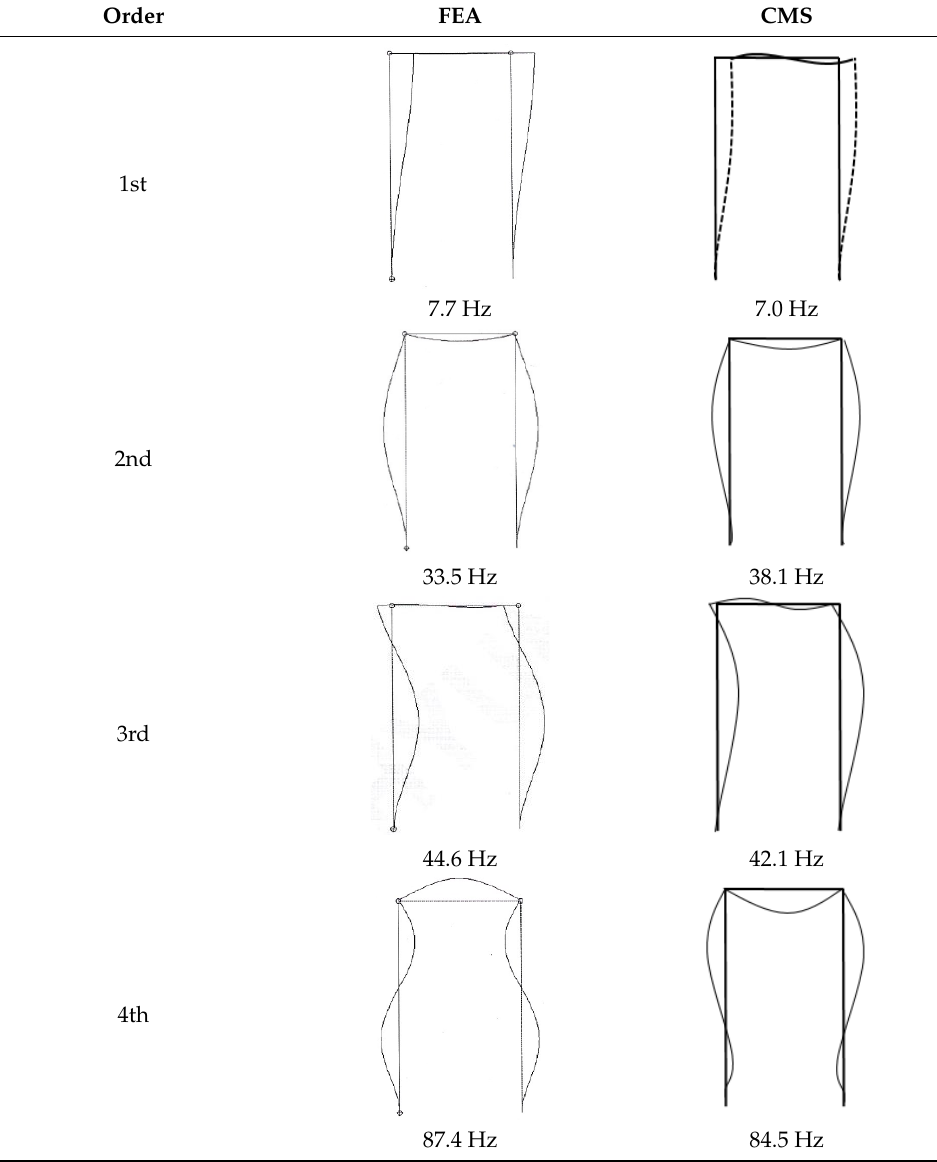
Table 6. The mode shape for each length ratio ( L A : L B : Lc = 5 m:2.5 m:5 m).